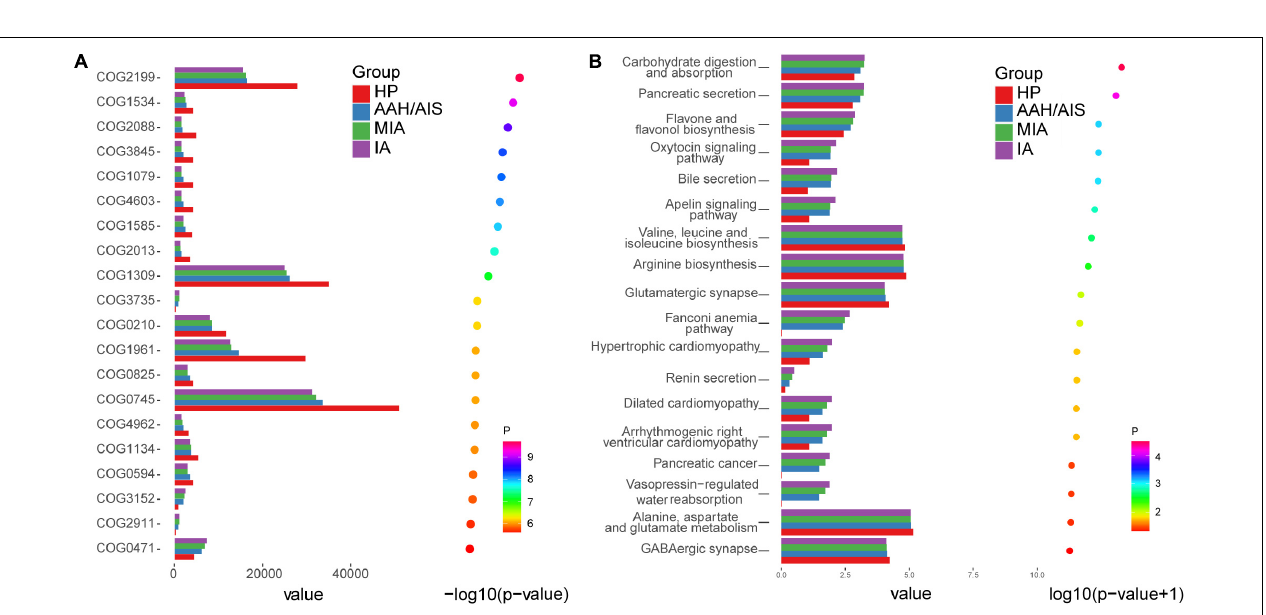
FIGURE 9 | COG pathway and KEGG analysis in the four groups. (A) The relative abundance of COG pathway differentially enriched in the four groups. (B) The relative abundance of KEGG pathway differentially enriched in the four groups.